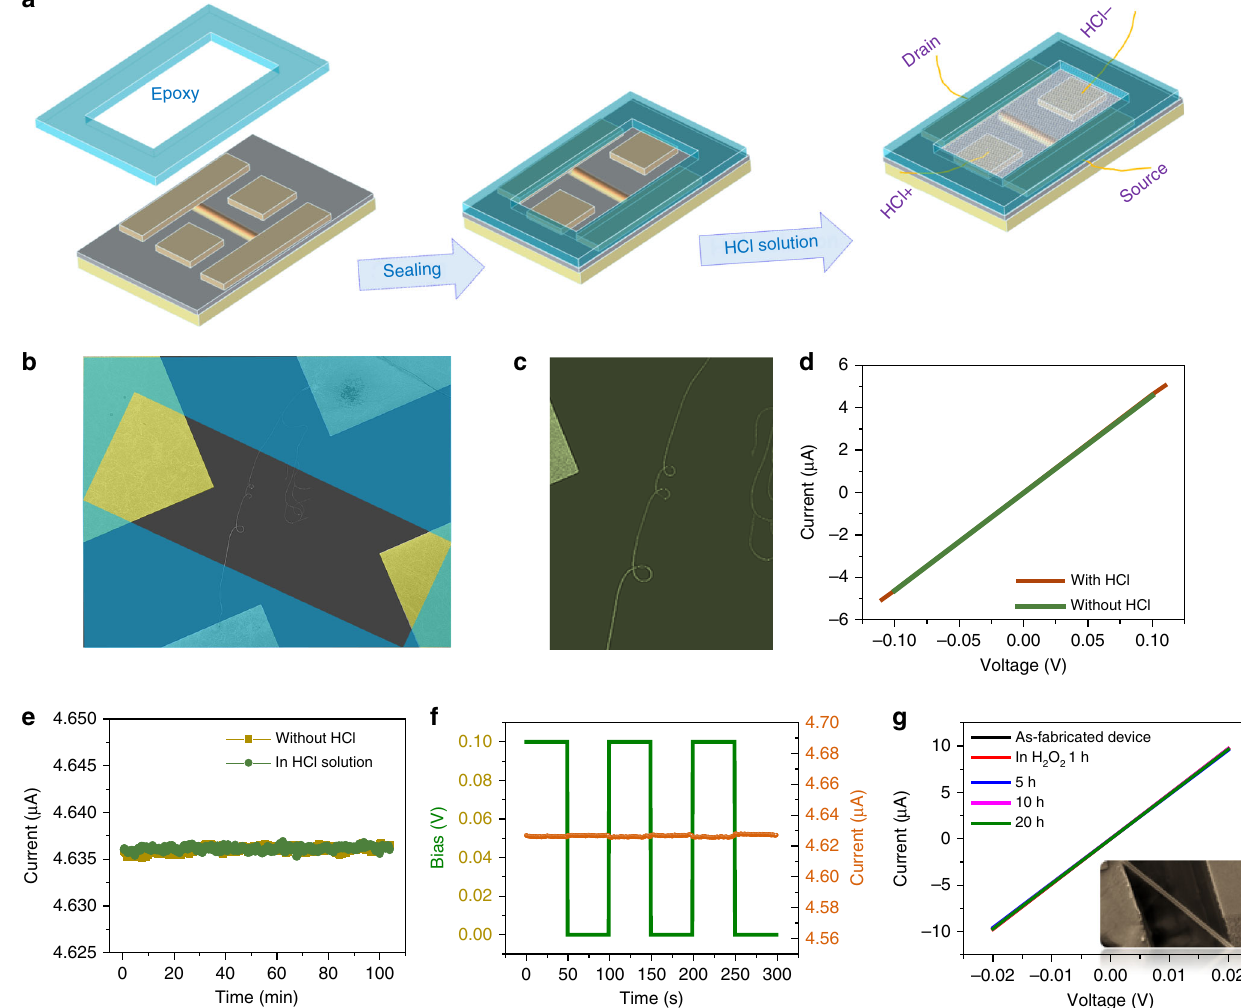
Fig. 5 Electrical availability to HCl and H 2 O 2 environments. a The fabrication schematic of the device for HCl shielding test. b Real device fabricated, the regions in aqua green would be sealed with epoxy. c The closer view of naked nanocable. d The I – V curves of the device with/without HCl solution fi lling. e The current-time evolution at constant voltage with/without HCl solution fi lling. f The current evolution (brown) driven by a constant voltage with a periodic pulsed electrical voltage (green) applied between HCl + and HCl − . g The I – V curves of the nanocable (inset) after being immersed in H 2 O 2